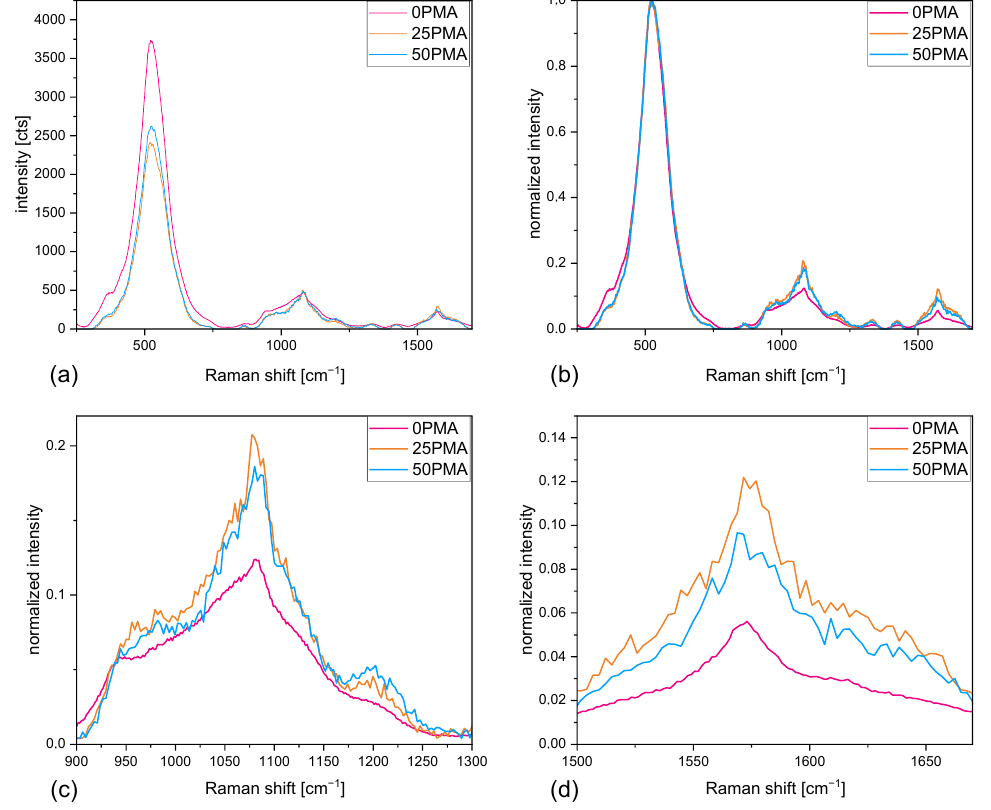
Figure 2. ( a ) Raman spectra comparison of measured intensities, ( b ) normalized Raman spectra, ( c ) zoomed-in section between 900 and 1300cm − 1 , ( d ) zoomed-in section between 1500 and 1700cm − 1